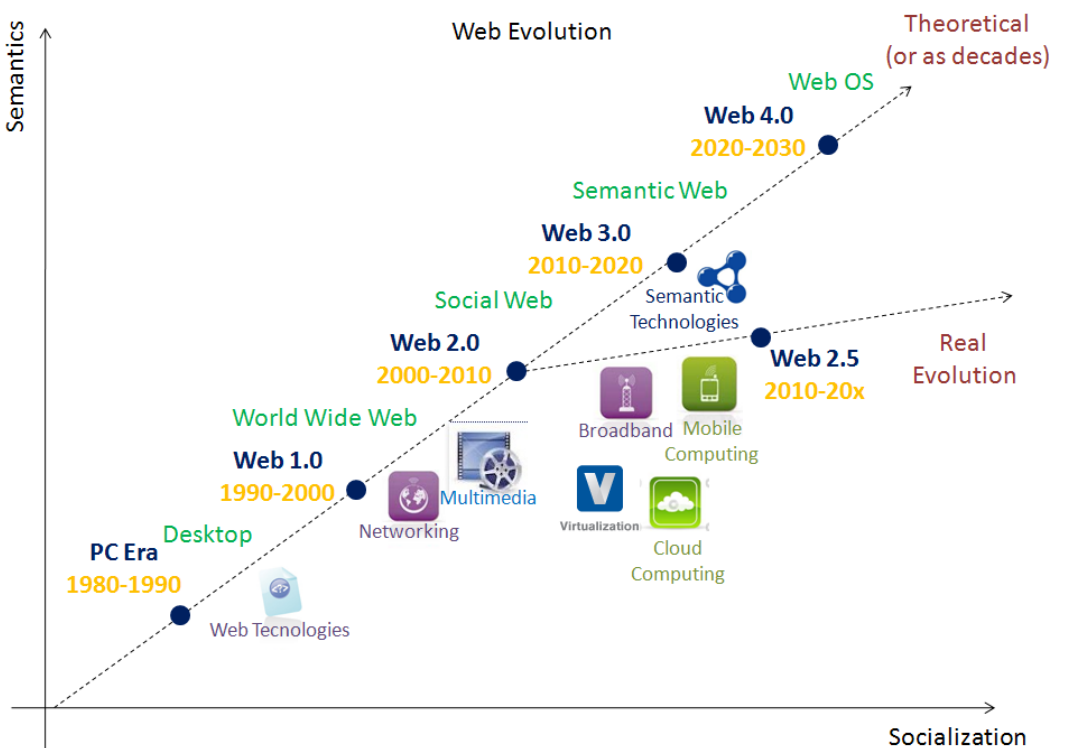
Figure 1. Theoretical vs . real Web